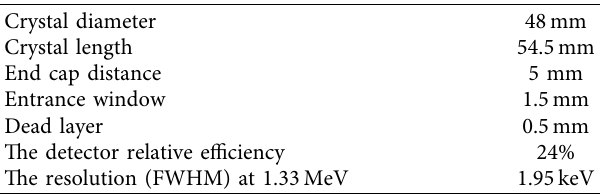
Figure 1: Illustration of the experimental setup. Table 1: Main technical characteristics of HPGe detector provided by the